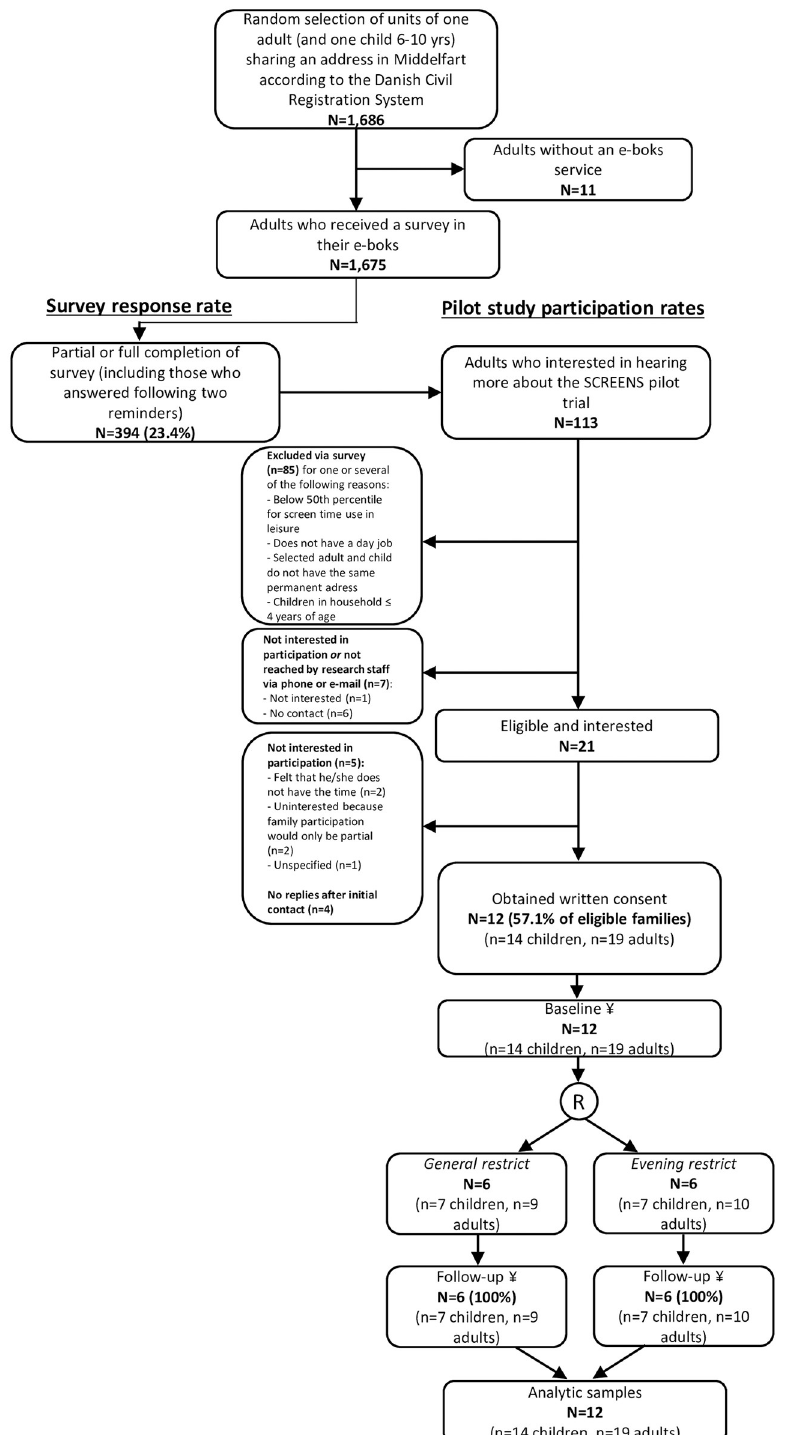
Fig 1. Flow chart of participants from sending out a survey to being included in statistical analyses. The flow chart above gives an overview of the steps of recruitment (electronic survey, phone contact, and meeting in households), SCREENS pilot trial participation and, finally, statistical analyses. Because the main goal of the study was to assess degree of compliance, families where included in the statistical analyses simply by not dropping out. Baseline and follow-up completion refer to objective measurement of screen media use and accelerometry. R; Randomization, ¥; Possible source of missing data.